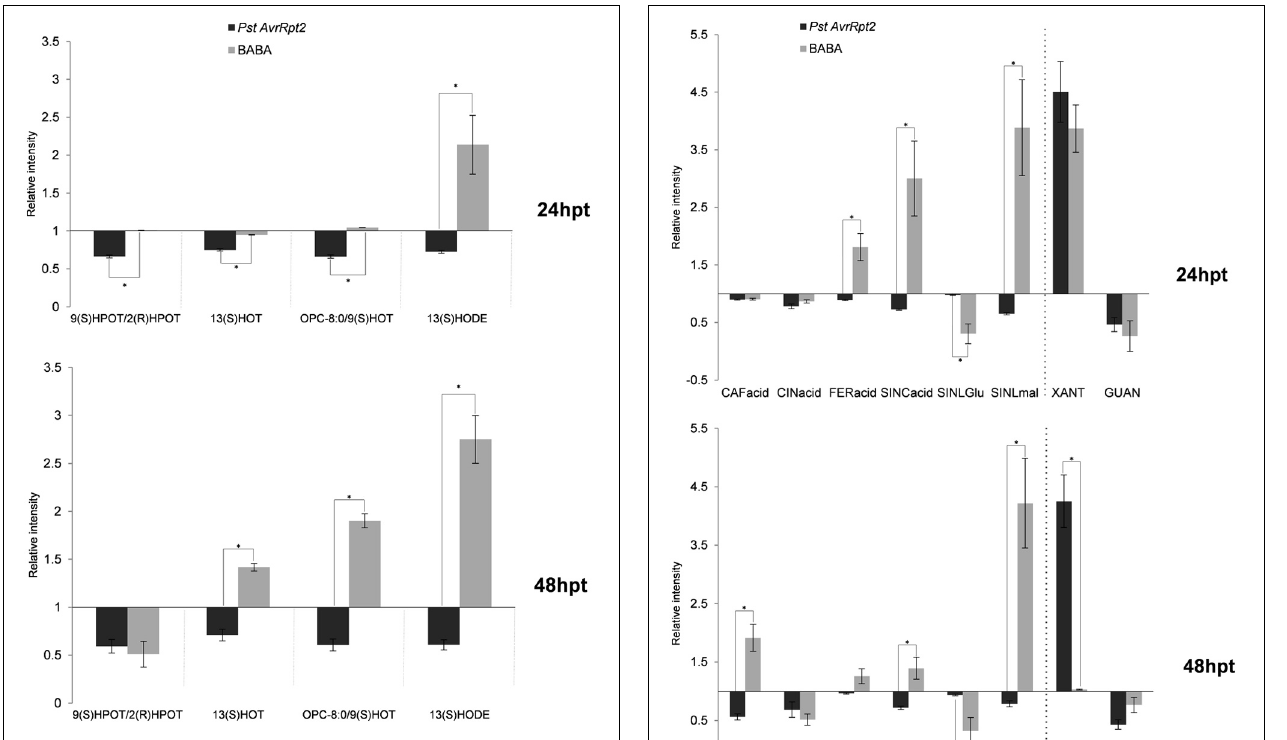
FIGURE 7 | Fatty acid production in priming. The experimental conditions and quantification were performed as explained above ( Figure 2 ). Asterisks represent statistically significant differences (Wilcoxon Mann–Whitney test, p < 0 . 05, n = 6). Data represent average of three independent experiments.